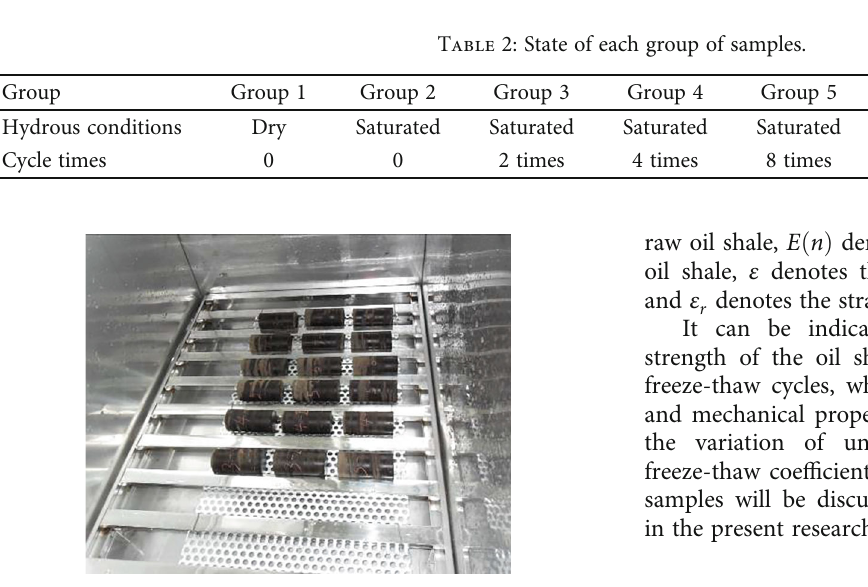
Figure 5: Samples in the periodic freeze-thaw experimental apparatus.